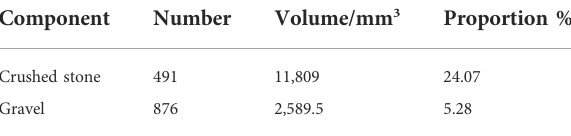
TABLE 3 Specimen internal component.